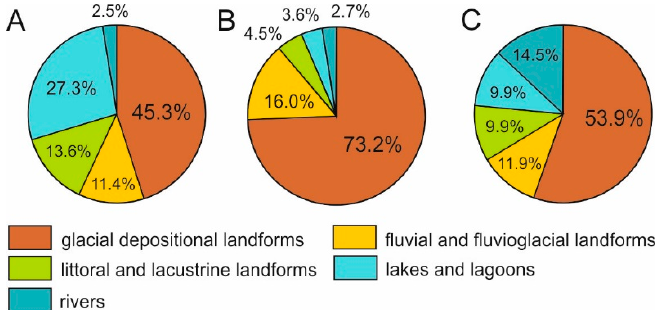
Figure 5. Share of groups of landforms in mapped area of forelands of ( A ) Ecology Glacier, ( B ) Sphinx Glacier and ( C ) Baranowski Glacier.